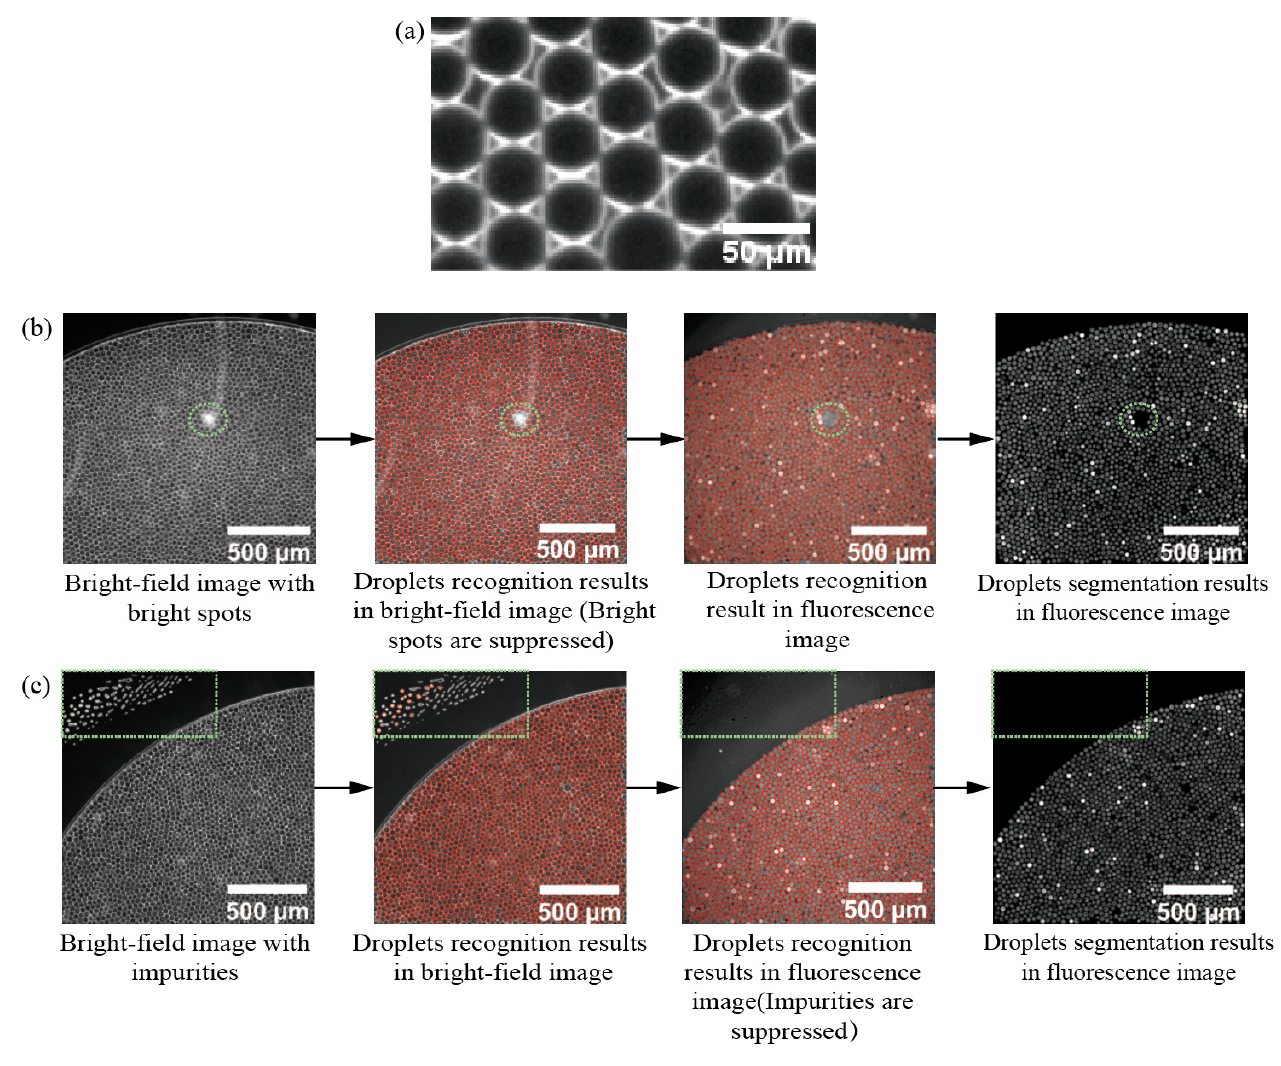
Figure 2. Localization, identification, and suppression of imaging noise in the result reading chip (the dotted circles in the figure represent bright spots or scratches, and the dotted boxes represent background impurities in the result reading chip). ( a ) The droplet outline is clearly shown in the bright-field image. ( b ) Suppression of bright spot contamination in images. The SimpleBlobDetector algorithm is applied to suppress bright spots by setting parameters such as area, roundness, and convexity of droplets in bright field image droplet recognition. ( c ) Suppression of impurity contamination in images. The intensity of the gray value of background impurities in the 16 bit fluorescence image is about 50% of the intensity of the gray value of negative droplets, and the background impurities can be suppressed on the fluorescence image by setting the threshold.